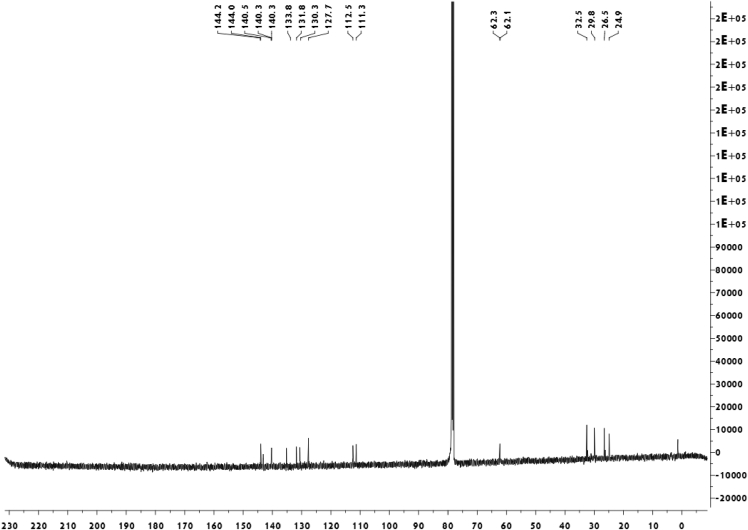
13C-NMR spectrum of meroterpenoid 9.